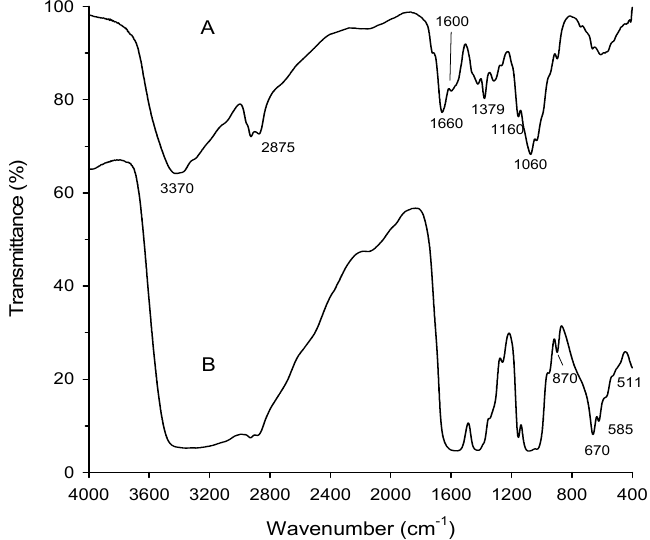
Figure 2. FTIR of chitosan ( A ) and the chitosan-MgO nanocomposite ( B ).